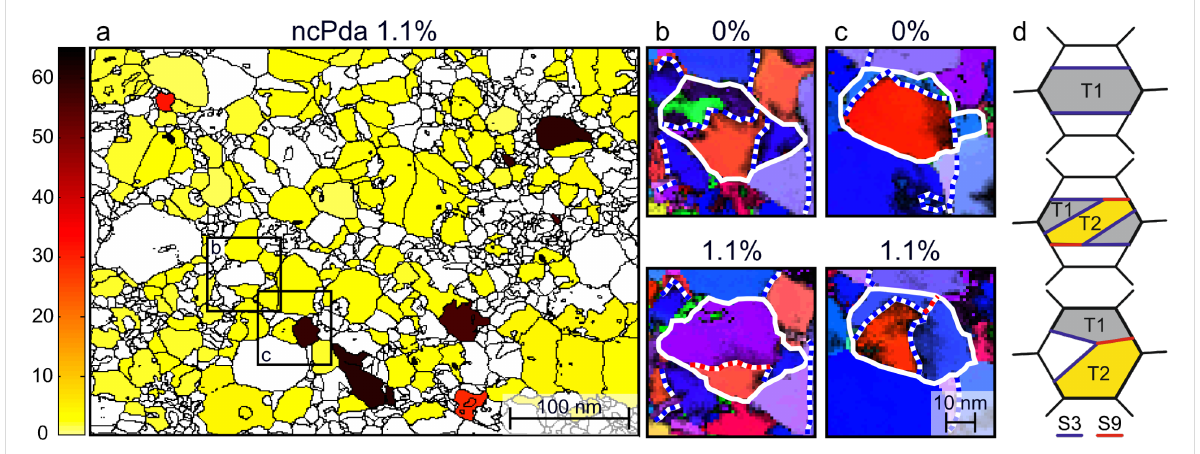
Figure 4: Analysis of the crystallite rotations in the range 0–65° for ncPda: (a) Crystallite boundary map overlaid with the rotation of selected and tracked crystallites for the 1.1% strain state. The color code is displayed on the left. (b,c) ACOM-STEM orientation maps of selected areas marked in (a). Σ 3 disorientations marked with white/blue dashed lines and Σ 9 disorientations marked with white/red dashed lines; the white boundary outlines the grain of interest. Projection direction: normal to the paper plane; color code is given in Figure 1c. (b) Details of a twin boundary activity. (c) Details of a grain that shows the creation of a triple line with two Σ 3 and one Σ 9 disorientation. (d) Schematic of the formation of Σ 3 and Σ 9 disorientations. The twin domains are labeled as grey/yellow areas, and the twin boundaries are indicated by the blue solid lines. The combination of two distinct twin variants (T1 in grey and T2 in yellow) results in a triple lines of two Σ 3 (blue) and one Σ 9 (red) boundary, which is equivalent to a chain of twin disorientation [46].